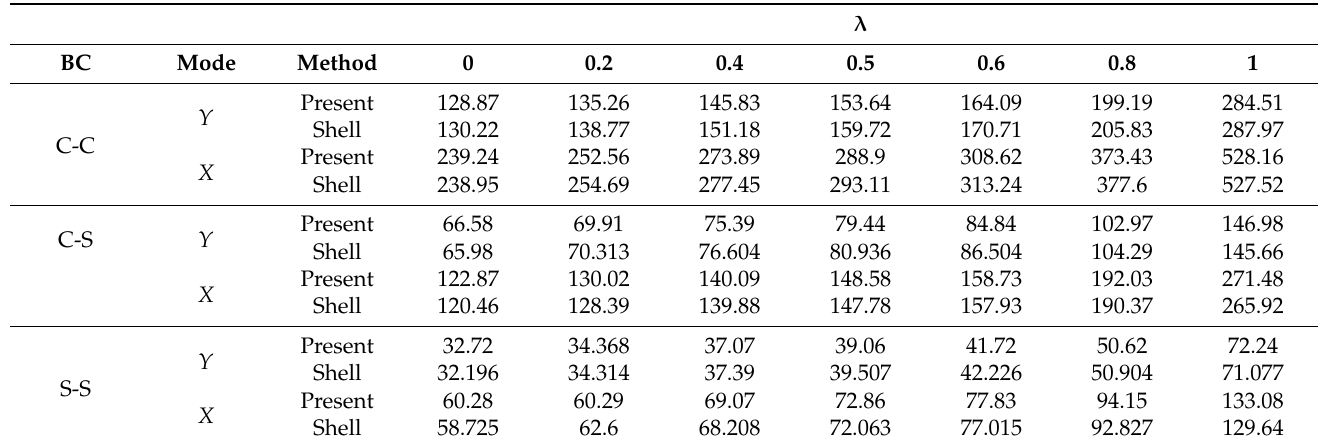
Table 2. Critical buckling temperatures of the beam L 1 = 6 m for different boundary conditions and material thickness ratios.